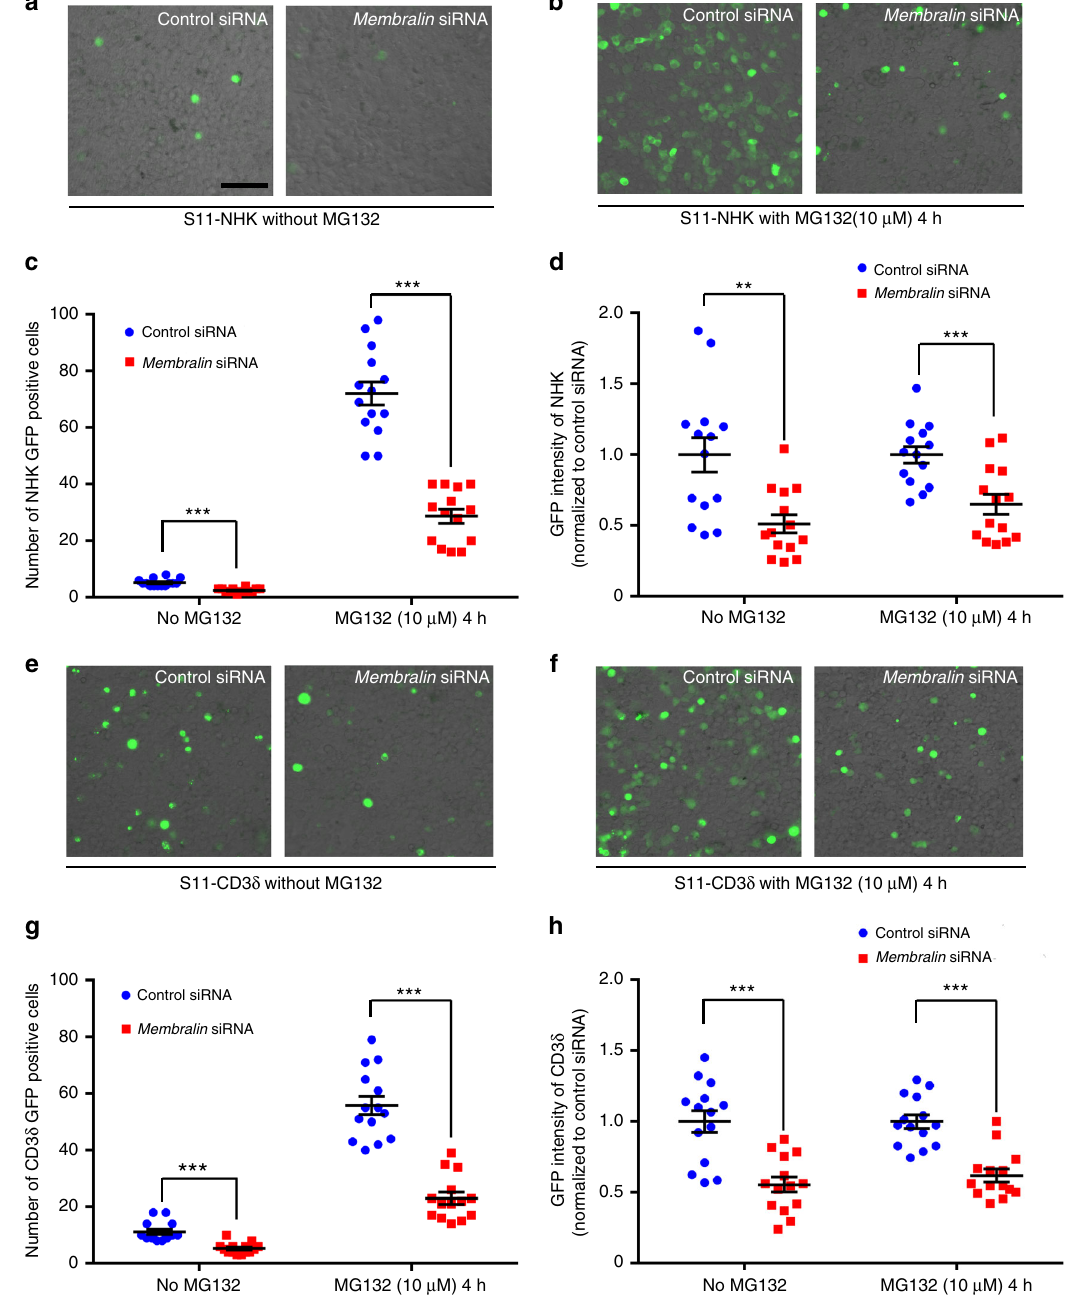
Fig. 3 NHK (ERAD-L) and CD3 δ (ERAD-M) degradation in HEK293T cells transfected with membralin siRNA. a Representative images depicting reconstituted NHK-GFP fl uorescence were shown from cells transfected with control or membralin siRNA and subsequently co-transfected with S1-10 and SP-S11-NHK-HA without proteasome inhibitor MG132 treatment. b Representative images of NHK-GFP-positive cells transfected with control or membralin siRNA and exposed to MG132 (10 µ M) for 4 h. c Quanti fi cation of NHK-GFP-positive cells with control and membralin siRNA transfection with or without MG132 treatment ( n = 14 random fi eld images per group). d Quanti fi ed GFP intensity in NHK-GFP-positive cells transfected with control or membralin siRNAs, with or without MG132 treatment ( n = 14 random fi eld images per group). e Representative images of reconstituted CD3 δ -GFP fl uorescence were shown from cells transfected with control or membralin siRNA and subsequently co-transfected with S1-10 and SP-S11-CD3 δ -HA without proteasome inhibitor MG132 treatment. f Representative images of CD3 δ -GFP-positive cells transfected with control or membralin siRNA and exposed to MG132 (10 µ M) for 4 h. g Quanti fi cation of CD3 δ -GFP-positive cells with control or membralin siRNA transfection with or without MG132 treatment ( n = 14 random fi eld images per group). h Quanti fi ed GFP intensity in CD3 δ -GFP-positive cells transfected with control or membralin siRNAs, with or without MG132 treatment ( n = 14 random fi eld images per group). Data represent mean ± s.e.m. from three independent experiments. *** P < 0.001, unpaired t -test. Scale bar, 100 µ